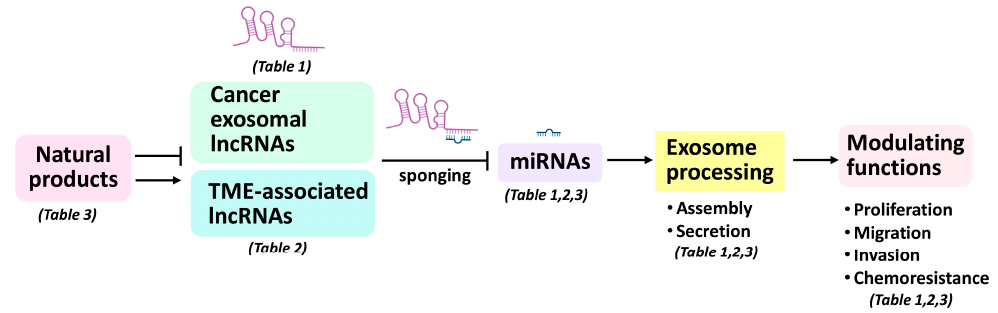
Figure 3. Schematic summary of the natural products acting on the exosomal lncRNA–sponging miRNA–exosomal process axis. Natural products may modulate (inhibit (T) or enhance (arrow)) cancer and TME-associated lnRNAs. Next, the lncRNAs may sponge miRNAs, and, in turn, miRNAs can modulate target exosome processing genes, providing modulating functions to cancer cells. More detailed information for each step has been mentioned in the Tables 1–3 above.